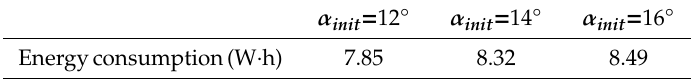
Figure 18. Instantaneous power in waypoint mission tracking for 𝛼 𝑖𝑛𝑖𝑡 = 12 ° ,14 ° ,and 16 ° . Table 4. Total energy consumption for 𝛼 𝑖𝑛𝑖𝑡 = 12 ° ,14 ° ,and 16 ° .